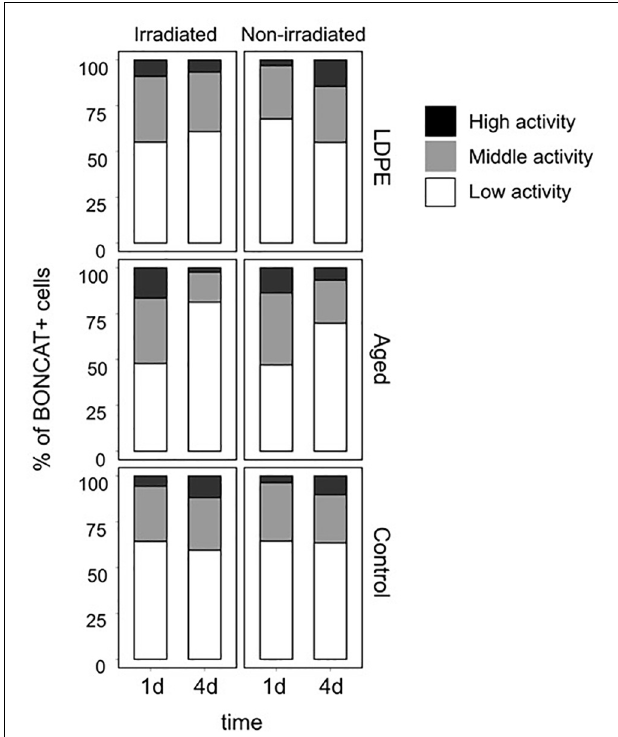
FIGURE 6 | Distribution of activity in the pool of active cells. Active cells were categorized as having low, medium, or high activity based on their BONCAT signal intensity, as in Sebastián et al. (2019) (see Section “Materials and